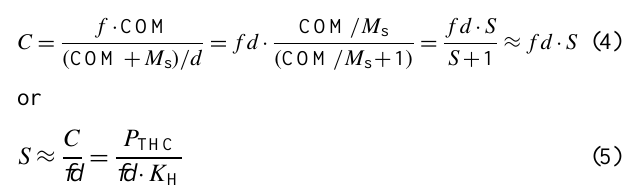
Figure 3. The COM/unit seed particle mass as observed, S , are derived as the slopes of organic mass versus seed particle mass for different particle sizes (e.g., Fig 2). Condensed mass from dissolution in the particle, relative to that at 150 nm seed particle, does not change with particle sizes (heavy dashed line); that from pure adsorption onto particle surface varies inversely with the surface area (light dashed line). The uncertainties in the slopes of COM versus seed particle mass are plotted for each S value.